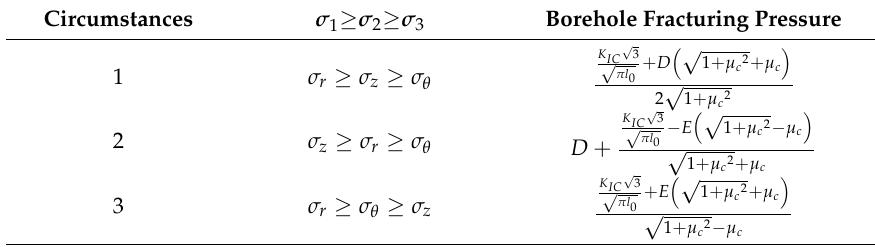
Table 7. Critical fracturing pressure for the fissured borehole